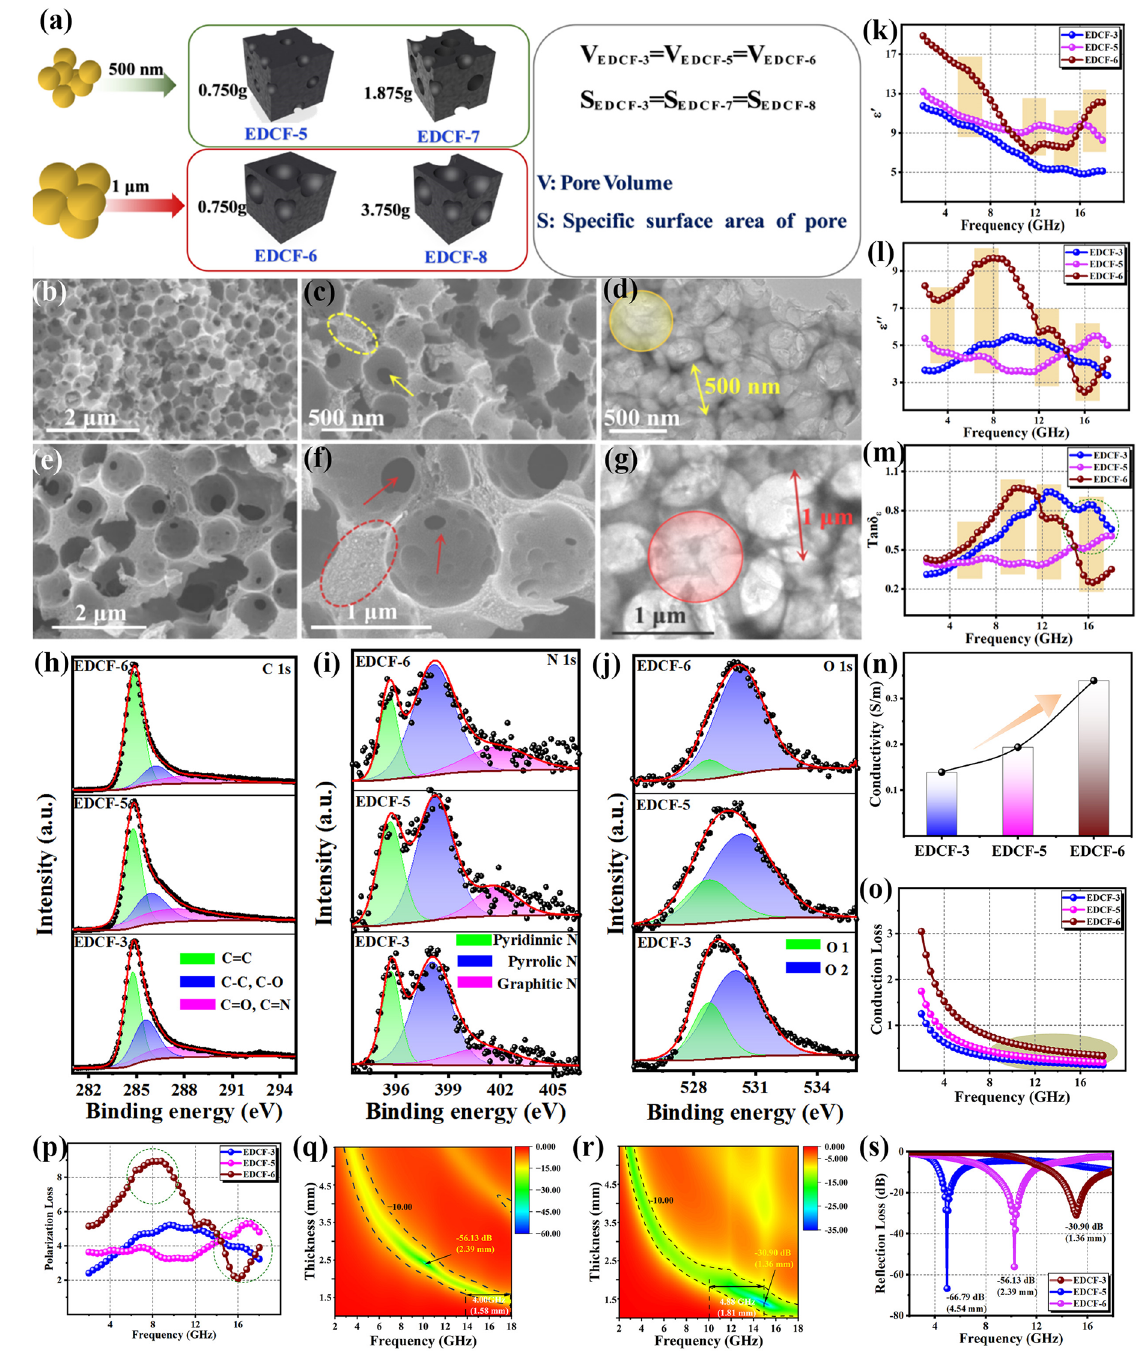
Fig. 4 a Schematic diagram of EDCF-5 and EDCF-7 constructed using 500 nm silica microspheres, and EDCF-6 and EDCF-8 constructed using 1 μm silica microspheres; b , c SEM images and d TEM image of EDCF-5 sample; e , f SEM images and g TEM image of EDCF-6 sample; high-resolution XPS spectra of h C 1 s , i N 1 s , and j O 1 s of EDCF-3, EDCF-5 and EDCF-6 samples; k the real part and l the imaginary part of the complex permittivity and m dielectric loss tangent for EDCF samples with the same pore volume; n conductivity values; o conduction loss curves and p polarization loss curves of EDCF-3, EDCF-5 and EDCF-6 samples; q RL diagram versus frequency of EDCF-5 and r EDCF-6 at different thickness; s comparison of the RL values of various EDCF samples at their optimal